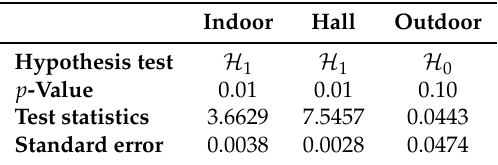
Table 3. Stationarity Kwiatkowski, Phillips, Schmidt, and Shin (KPSS) test for all scenarios (with no audio